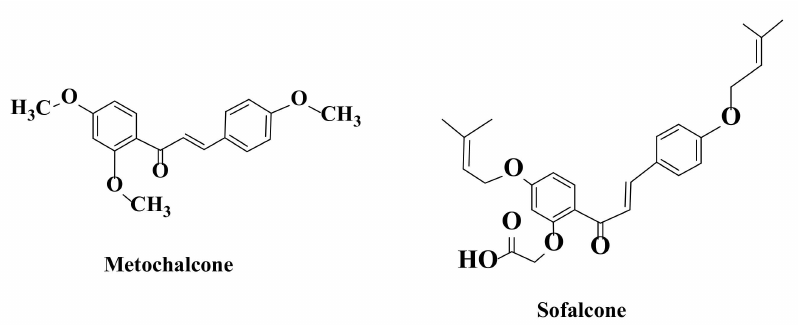
Figure 5. Structure of metochalcone and